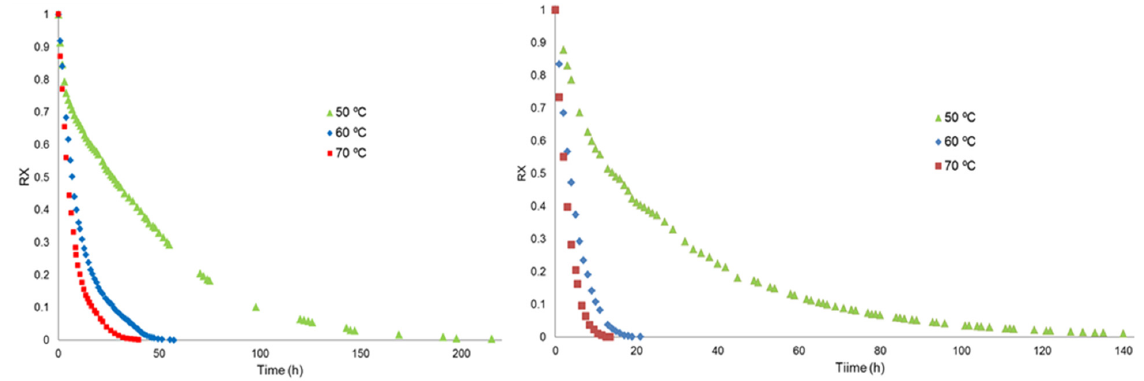
Figure 5. Drying curves of prickly-pear cladodes with different geometries (( left ) straps, ( right ) cu- bes).